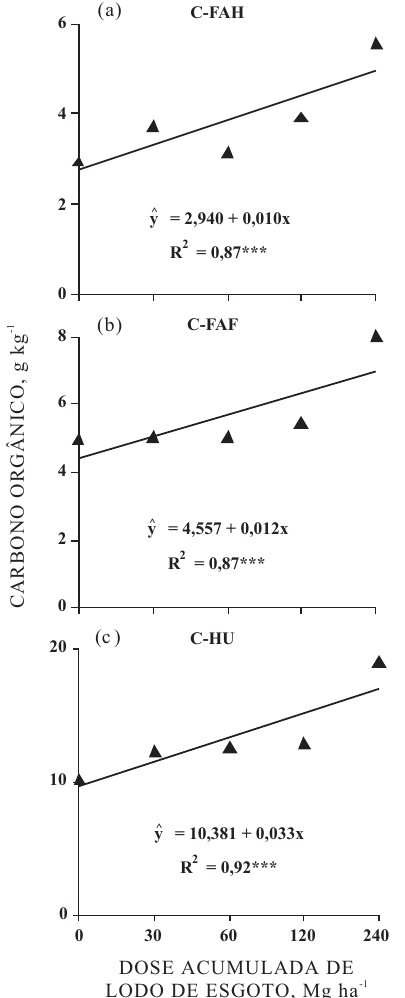
Figura 3. Teores de carbono associados às frações ácido húmico (a), ácido fúlvico (b) e humina (c) em Latossolo sucessivamente tratado com lodo de esgoto. (***: Significativo a 0,1